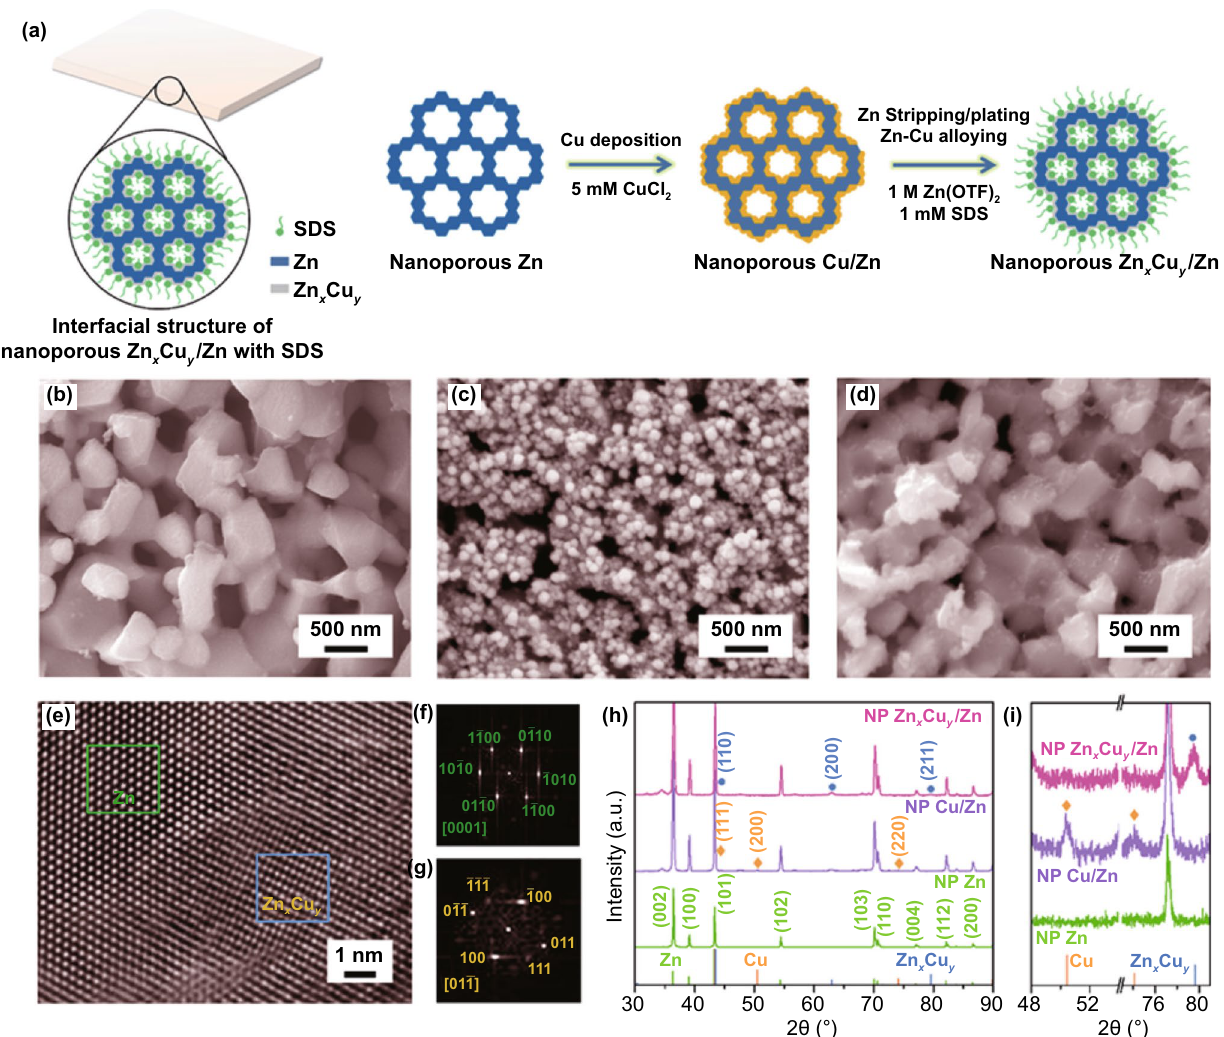
Fig. 1 Schematic and microstructural properties of nanoporous Zn‑based electrodes. a Schematic illustration for nanoporous shell/core Zn x Cu y / Zn sheets that are fabricated by surface alloying of Cu and Zn of Cu‑decorated nanoporous Zn during sodium dodecyl sulfate (SDS)‑assisted electrochemical Zn stripping/plating cycling. b SEM image of nanoporous Zn electrode that is prepared by chemically dealloying Zn 50 Al 50 alloy sheets in KOH solution. c SEM image of nanoporous Cu/Zn hybrid electrode, in which Cu nanoparticles with diameter of ~ 50 nm are deposited on surface of nanoporous Zn skeleton via a galvanic replacement reaction. d SEM image of surface‑alloyed nanoporous Zn x Cu y /Zn electrode after SDS‑assisted Zn stripping/plating in Zn(OTF) 2 for 10 cycles. e HRTEM image of Zn x Cu y /Zn interface of nanoporous Zn x Cu y /Zn electrode. f , g FFT patterns of HCP Zn (f) and cubic Zn x Cu y (g) phases corresponding to green and blue squares in e . h Typical XRD patterns of nanopo‑ rous Zn, Cu/Zn and Zn x Cu y /Zn electrodes. The line patterns show reference cards 65‑3358 and 85‑1326, 02‑1231 for monometallic Zn and Cu, Zn x Cu y alloy according to JCPDS, respectively. i A magnification of XRD patterns of nanoporous Zn, Cu/Zn and Zn x Cu y /Zn electrodes at the characteristic diffraction peak regions of monometallic Cu and Zn x Cu y